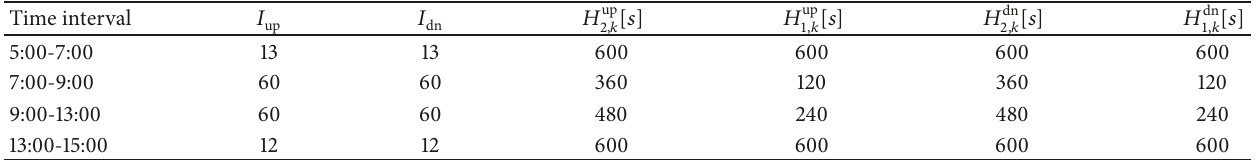
Table 7: Input parameters for case